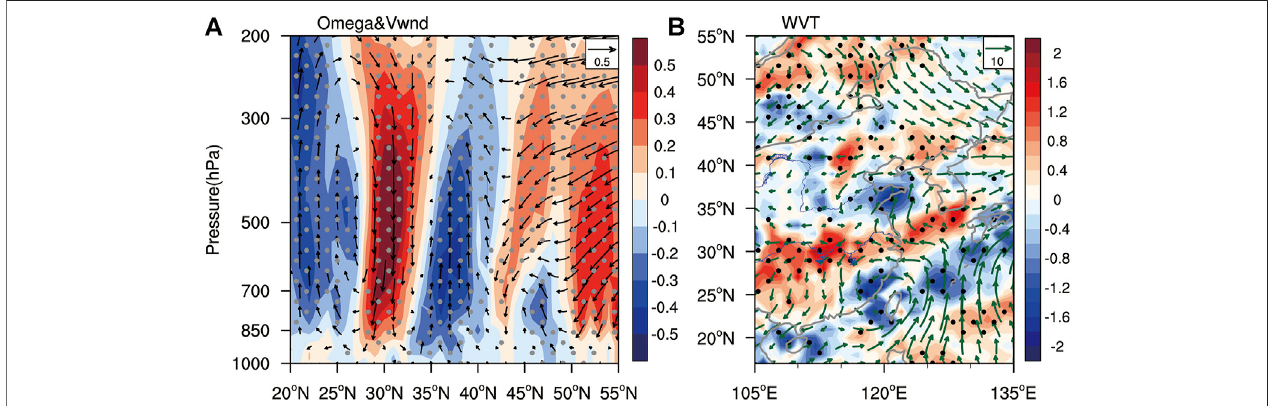
FIGURE 11 | Regression maps of the 9-years low-pass fi ltered circulations in summer (JJA) with regard to the SSDI. (A) The pressure-latitude cross-section of meridional velocity (vector; m s − 1 ) and vertical velocity (shading; 10 – 2 Pa s − 1 ) averaged along 110 ° – 120 ° E. (B) water vapor transport (vector; 100 kg m − 1 s − 1 ) vertically integrated from surface to 300 hPa and its divergence (shading; 10e − 7 kg m − 2 s − 1 hPa − 1 ). The stippling denotes the regression coef fi cients statistically signi fi cant at the 95% con fi dence level.